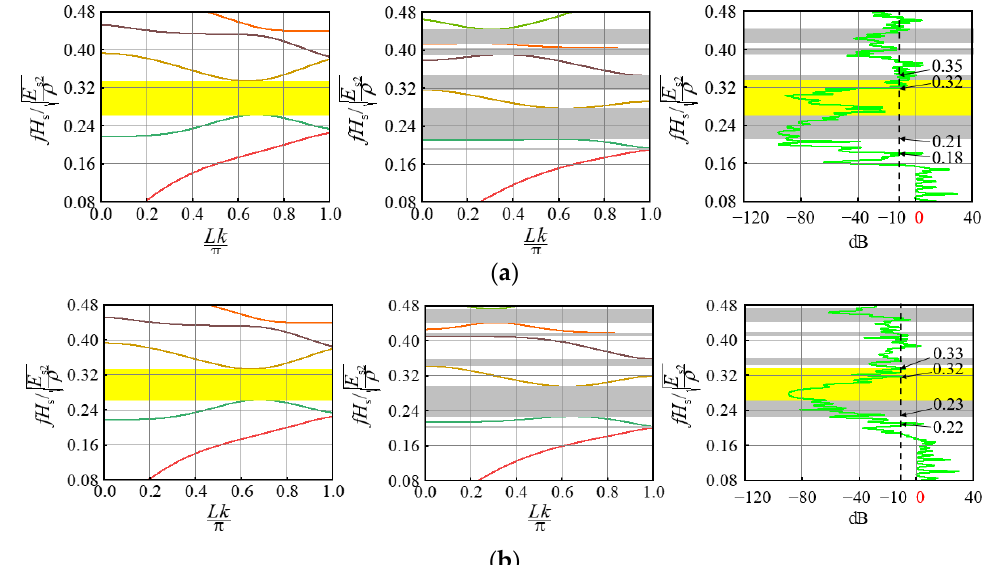
Figure 7. Influence of thickness ratio E s1 / E s2 on the band gap: ( a ) 77.0 × 10 − 4 and 23.0 × 10 − 4 ; ( b ) 77.0 × 10 − 4 and 47.0 × 10 − 4